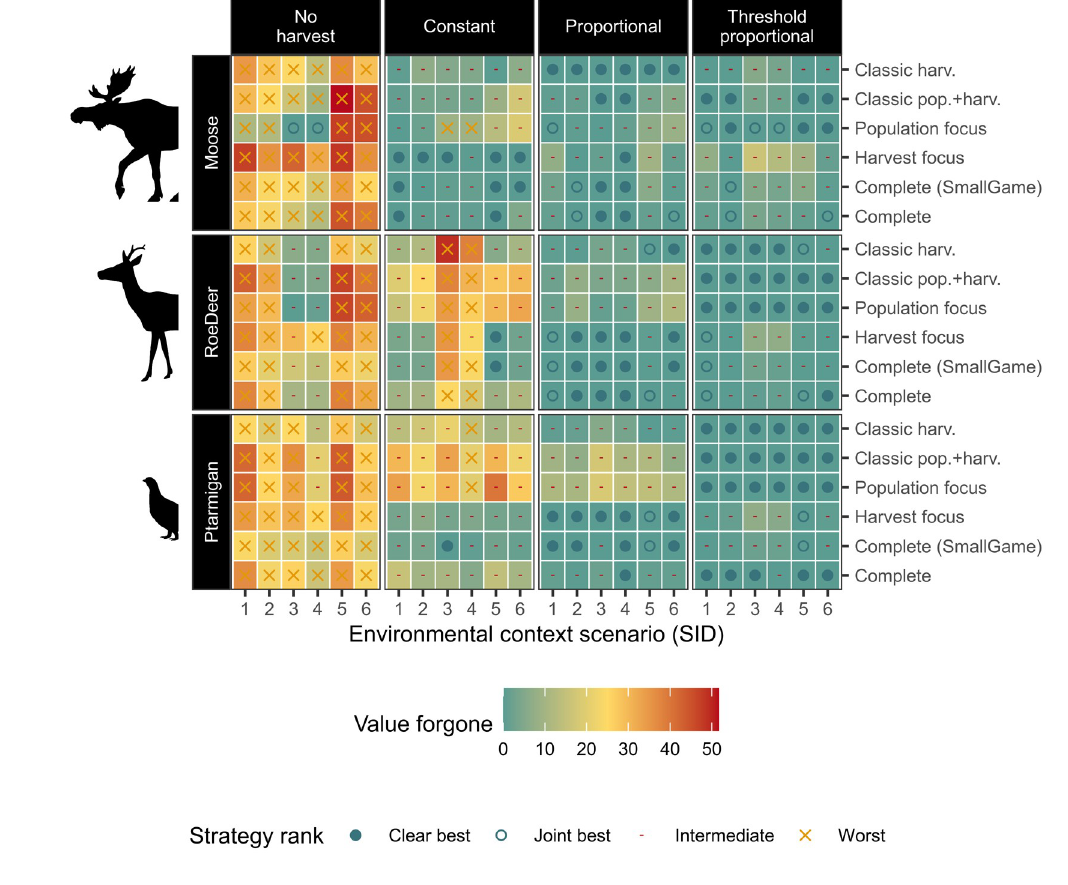
Fig 6. Optimal strategy, and value forgone through choice of harvest strategy, across environmental and evaluation contexts. Harvest strategy optimality (symbol), and value forgone (tile colour) by using the harvest strategy in each environmental and evaluation context, instead of the optimal strategy for the respective environmental and evaluation context. Harvest strategies (panel columns) are represented by their optimal harvest parameter outcomes. Environmental contexts are combinations of species type (panel rows), and starting population and variability (SID codes are described in Fig 1; x-axis). Strategies are compared for optimality only within equivalent species x environmental x evaluation comparisons. This figure shows how proportional and threshold proportional strategies are typically the most optimal, and typically result in lower value forgone when not. Differences are further summarised in text and the following figures.